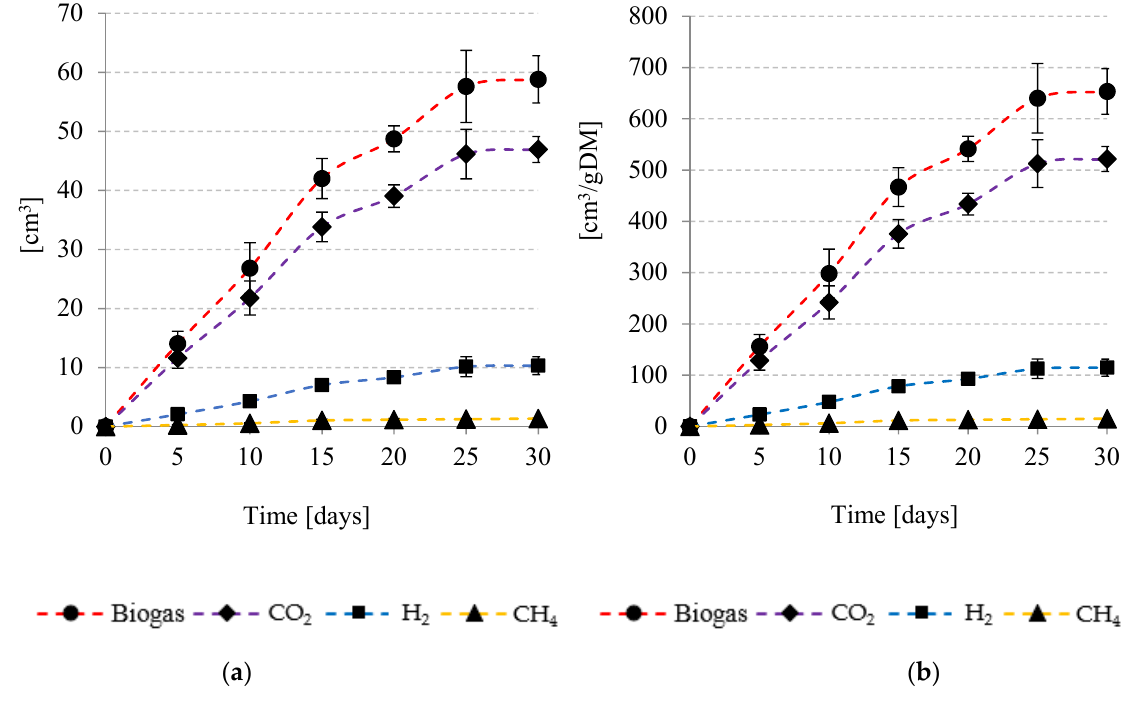
Figure 1. Build-up of biogas and its main constituents ( a ) total ( b ) per unit.